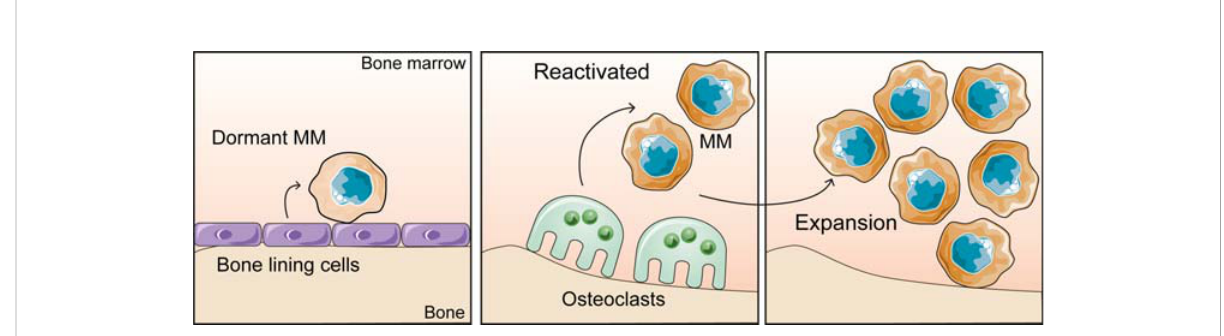
FIGURE 2 The bone microenvironment controls the myeloma growth dynamics. Dormant myeloma cells associate with bone lining cells and osteoblasts on the bone surface. Bone resorption by osteoclasts releases myeloma cells from dormancy and promotes tumour